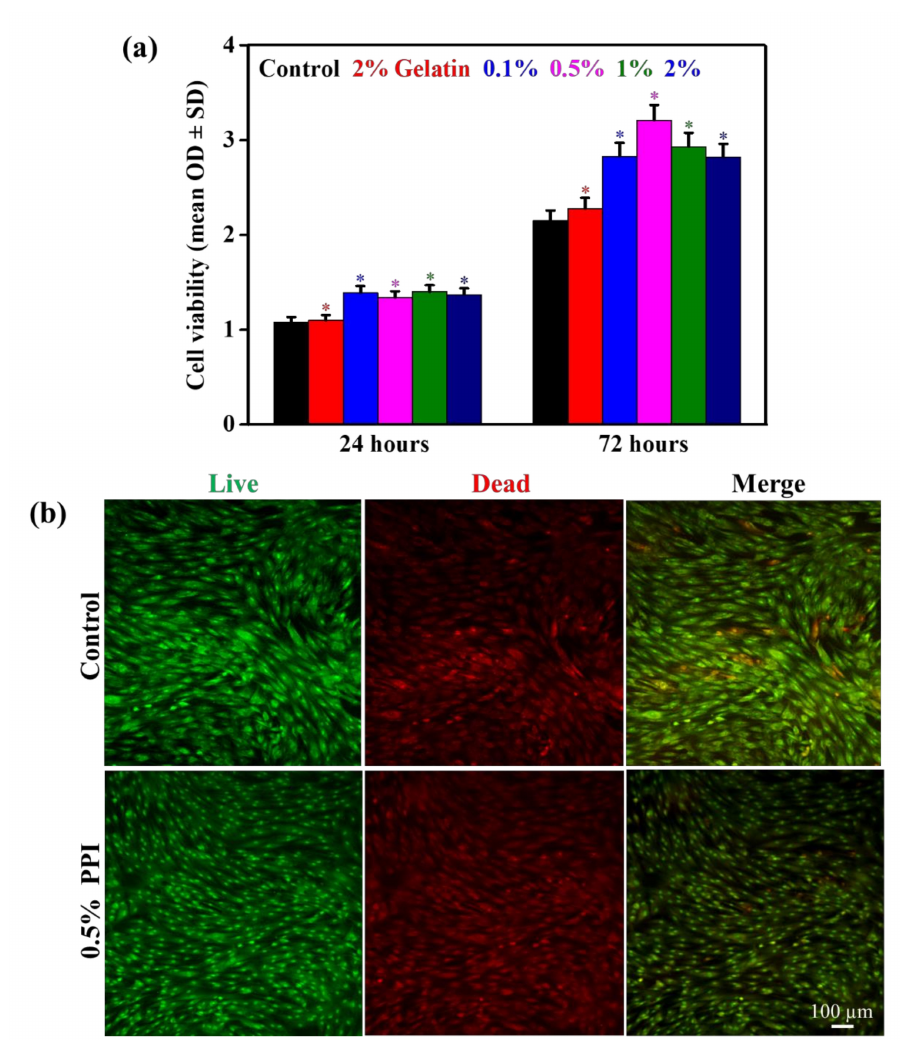
Figure 5. In vitro cytotoxicity evaluation of PPI on hBMSCs at indicated time intervals. ( a ) WST-1 assay of PPI-treated hBMSCs. ( b ) Live / dead assay of 0.5% PPI-treated hBMSCs after a three-day